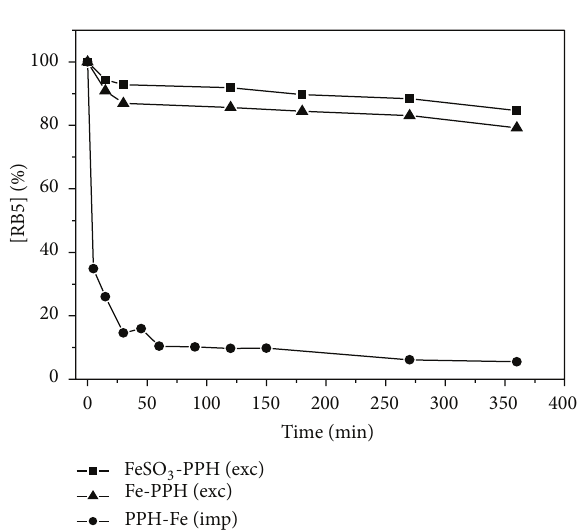
Figure 2: RB5 decolourization through heterogeneous Fenton’s reaction using three different PPH with Fe 2+ . [RB5] = 50 mgL −1